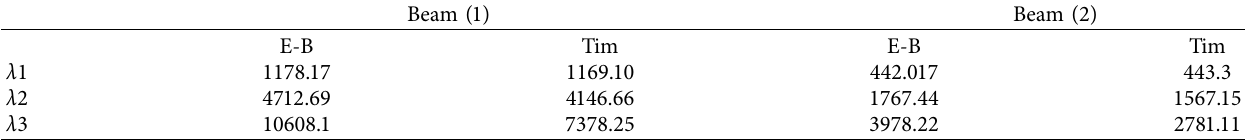
Table 4: Current values of the natural frequencies.